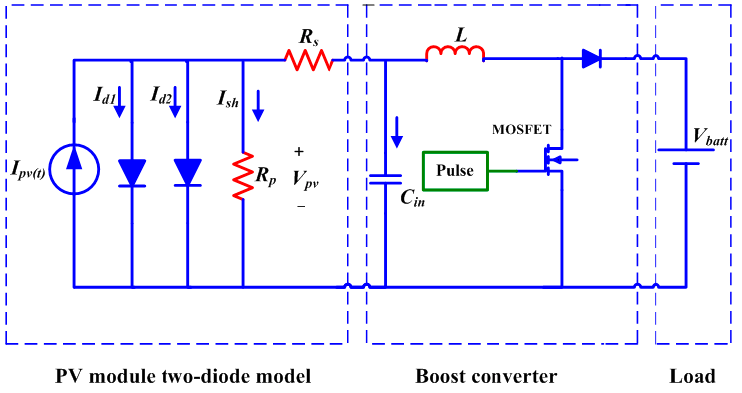
Figure 2. Circuit diagram the proposed PV system.